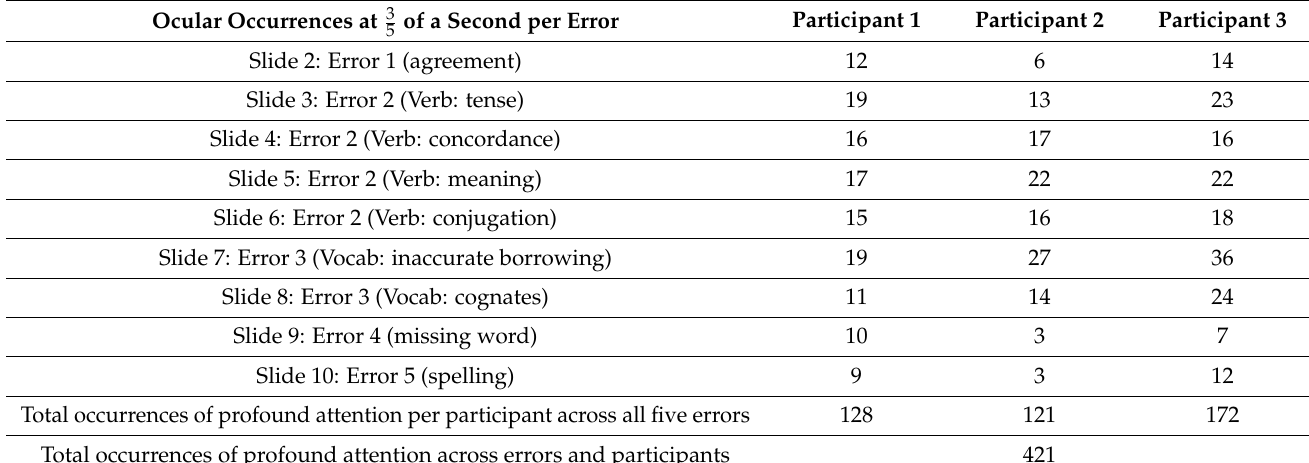
(Table 9). Similar to the ocular patterns (i.e., linear and nonlinear) and for the same reasons, the eye-gaze activity recorded in the introduction of the tutorials were also excluded. Table 9. Errors that received the most attention.